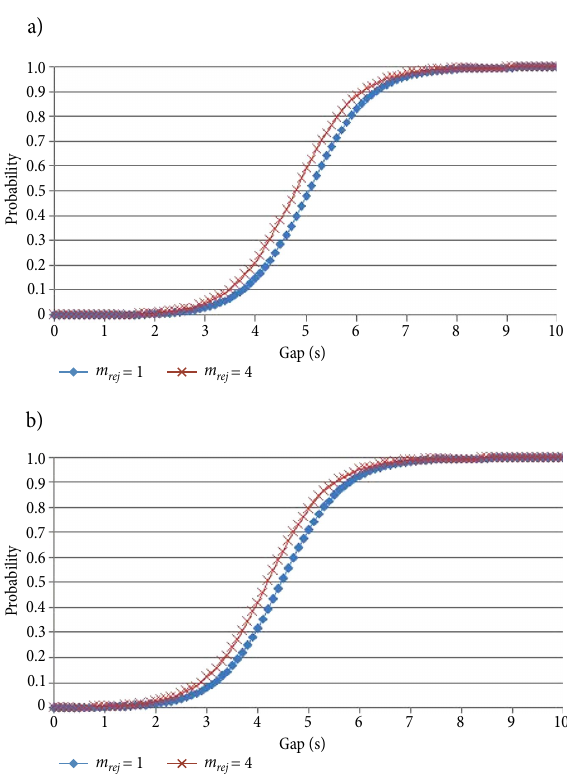
Fig. 1. Gap acceptance probability functions by the number of rejected gaps: a – m rej =1 s; b – m rej = 4 s